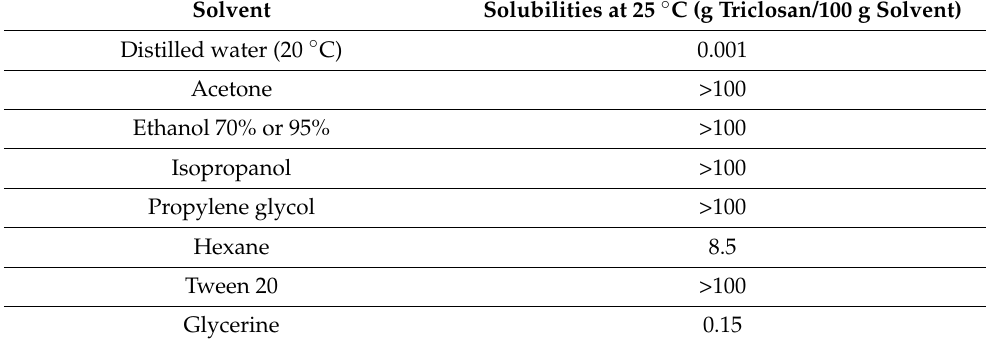
Table 2. Solubility of triclosan in different solvents [27,28] .